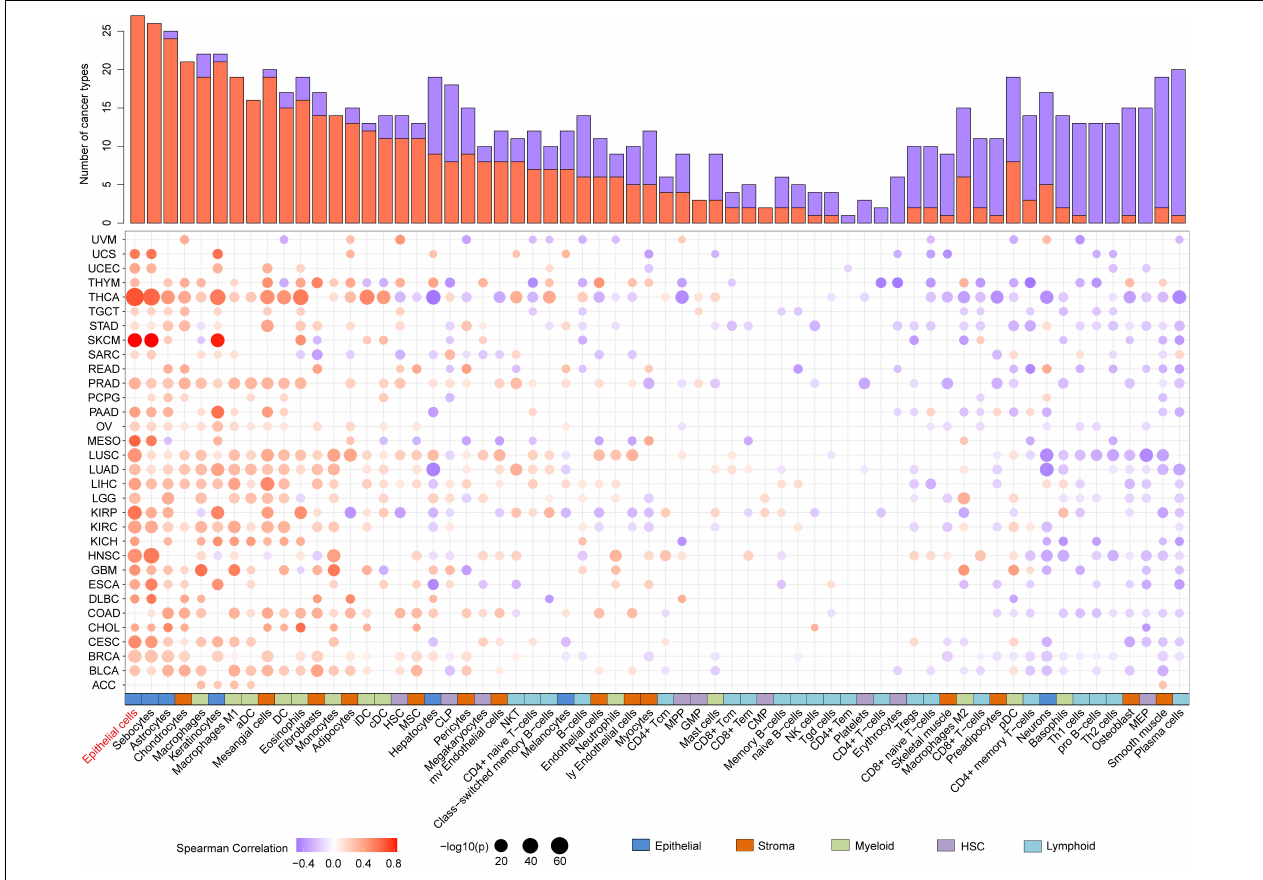
FIGURE 5 | Association analysis between the expression of CST6 and tumor microenvironment in TCGA datasets. Histogram height represents the number of cancer types with significant correlation between CST6 and cell infiltration score. Red- and purple-colored bubbles denote positive and negative correlation. Colored bar on the bottom denotes cell subgroup obtained from